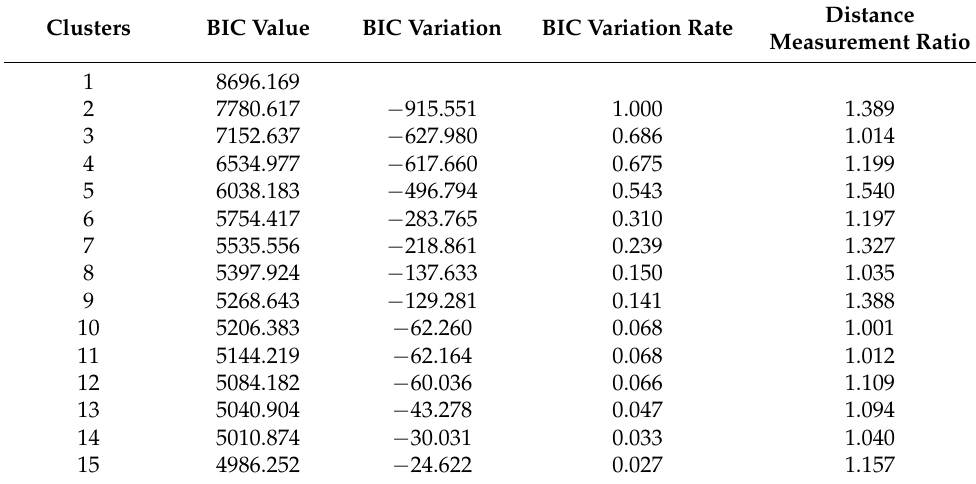
Table 3. Parameters of two-step cluster analysis.